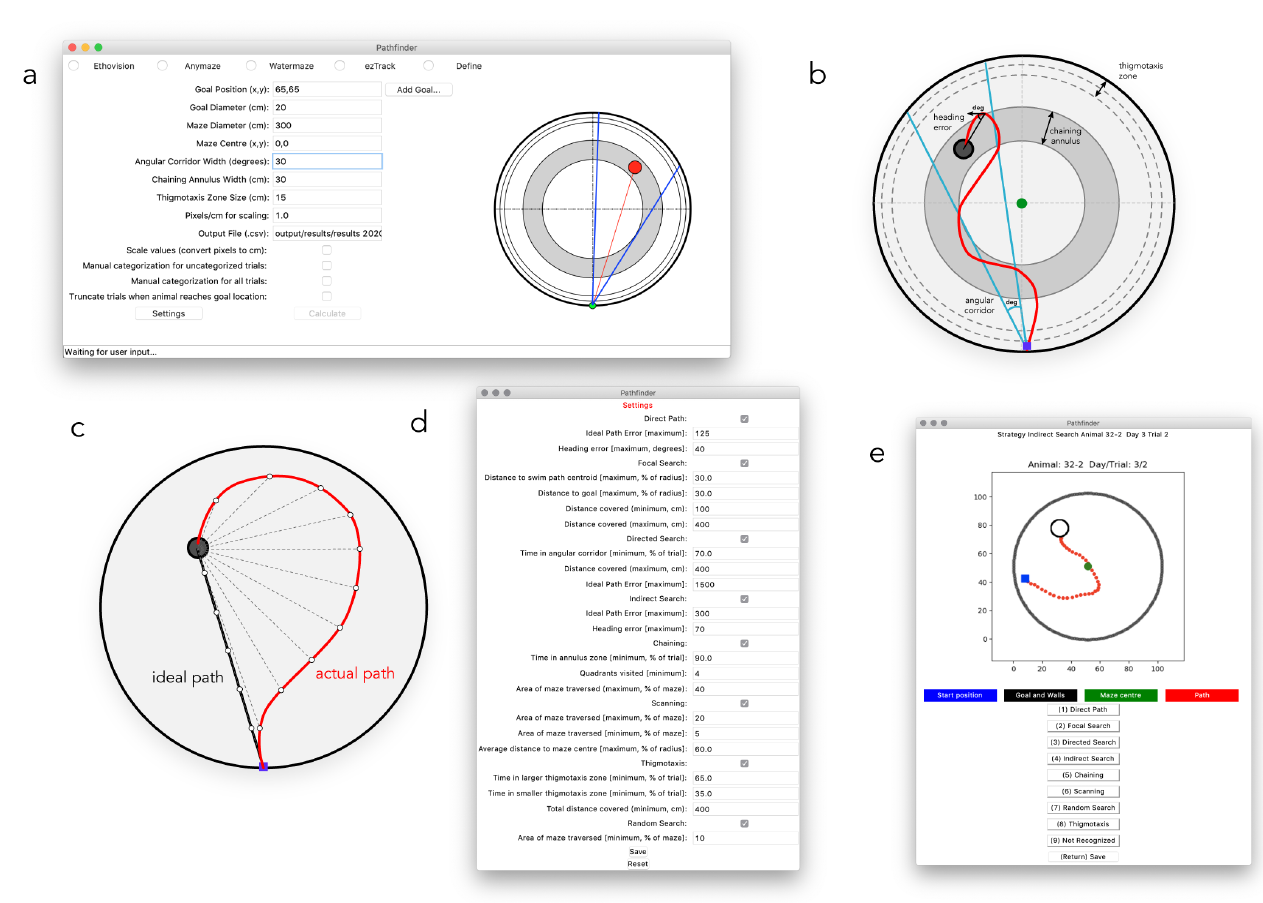
Figure 1. Graphical user interface and setting parameters. a ) Screenshot of the main application window, where maze geometry is defined, and input and output settings are established. On the right there is a live view of the parameters defined. b ) Maze schematic and geometry for defining variables. The chaining corridor is centered on the goal platform and extends throughout all 4 quadrants; its width is specified in the main window. The larger thigmotaxis zone is specified in the main window; Pathfinder calculates the smaller thigmotaxis zone as half the width. Heading error is the angular distance between the actual path direction and a straight line to the goal (Pathfinder calculates average heading error at all points; only a single example shown). The angular corridor is used to define the directed search strategy, which depends on the accuracy of the animal’s trajectory as it approaches the platform. The width of the corridor (in degrees) is specified in the main window and is centered on the goal. c ) Schematic of the Ideal Path Error (IPE) metric. The distance from the platform is measured at each timepoint provided by the tracking software (actual path; only a fraction of distances shown for clarity) to provide a cumulative distance measure. Assuming the same swim speed as the actual path, distances are similarly summed from the ideal path, to provide a cumulative ideal path measure. The ideal cumulative distance is subtracted from the actual cumulative distance to generate the IPE. d ) Parameter bounds are entered in the settings window. e ) The manual categorization window, for viewing trial paths and manually categorizing